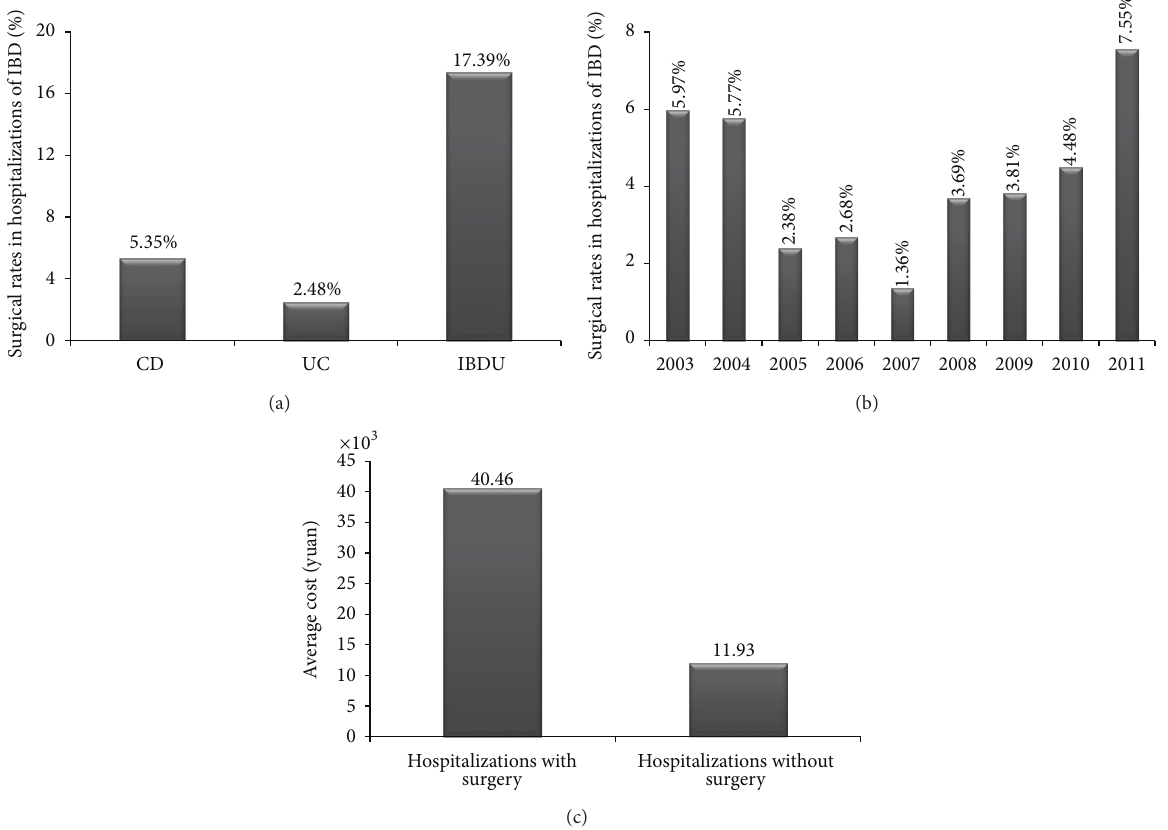
Figure 7: Surgery and costs in IBD. (a) Surgical rates in hospitalizations of IBD; (b) surgical rates changed in the last decade; (c) the costs were significantly higher in hospitalizations with surgery than in hospitalizations without